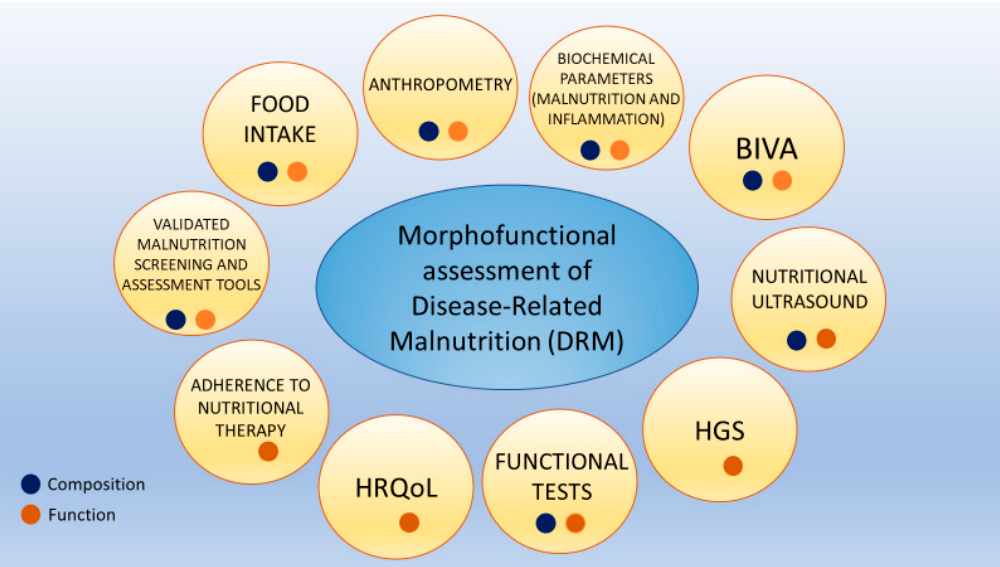
Figure 1. Morphofunctional assessment of disease-related malnutrition. Each assessment area can provide insights into body composition, body function, or both. Abbreviations. HRQoL: health-related quality of life; HGS: hand grip strength; BIVA: bioelectrical impedance vector analysis). To interpret the color references in this figure legend, please see the Web version of this article. Source: own elaboration.